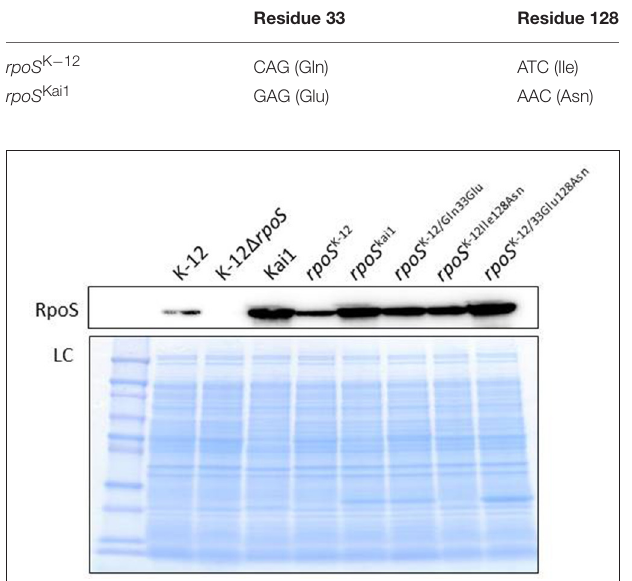
TABLE 1 | Missense point mutations in rpoS in Kai1 strain.